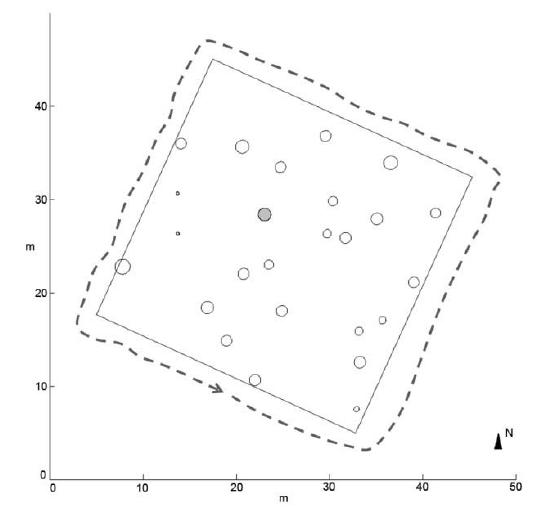
Figure 1. The test forest plot and the photographing path . The square area represents the test plot boundary. The circles and their diameters show the tree locations and the corresponding DBHs. The grey circles indicate deciduous trees and the other circles are pine trees. The dashed lines indicate the photographing